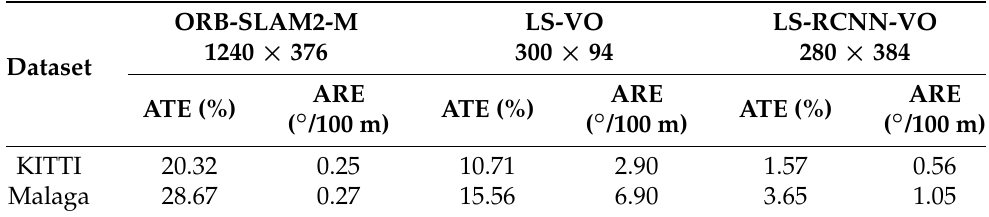
Table 4. Comparison with other works according to average translation error (ATE) and average rotational error (ARE).